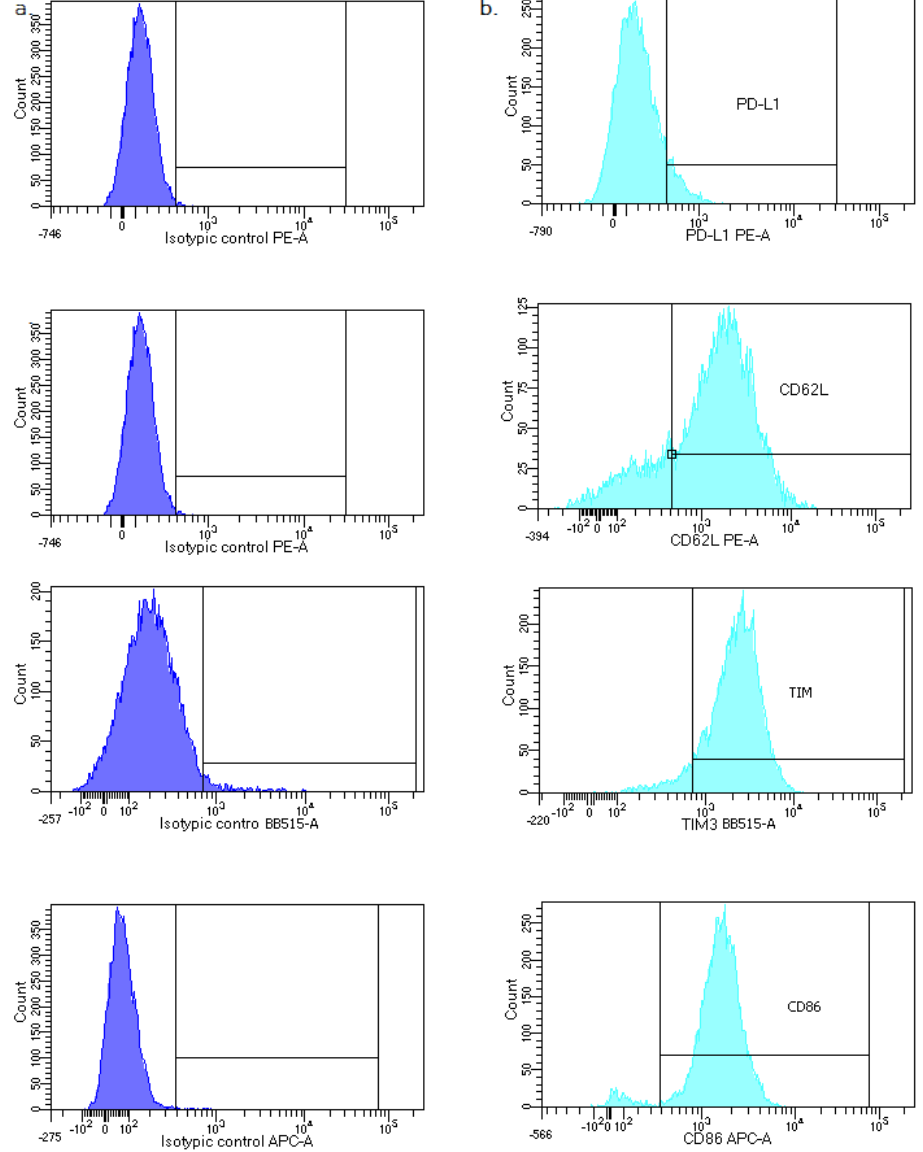
Figure A2. FACS analysis of isotype controls for PD-L1- PE, CD62L-PE, TIM-3-BB515 and CD86-APC. ( a ) Isotype control. ( b ) Representative histograms with PD-L1, CD62L, TIM-3 and CD86 expression in COVID-19 patients.